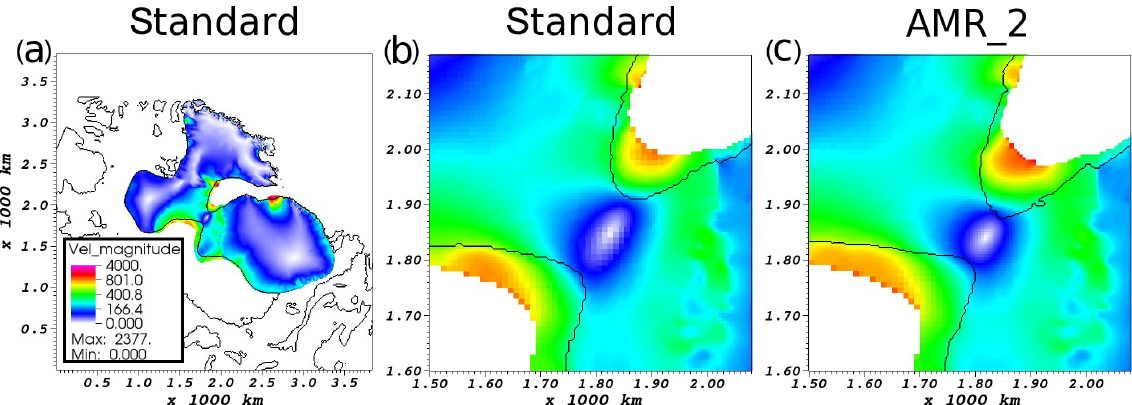
Figure 7. Magnitude of vertically integrated ice velocity (ma − 1 ) at model year 1700 with the grounding line and coastlines shown in black. The three panels follow the scale shown in panel (a) . (a) The velocity over the whole domain in the standard simulation. (b) A zoomed-in view of the ice saddle in the standard and (c) in AMR_2